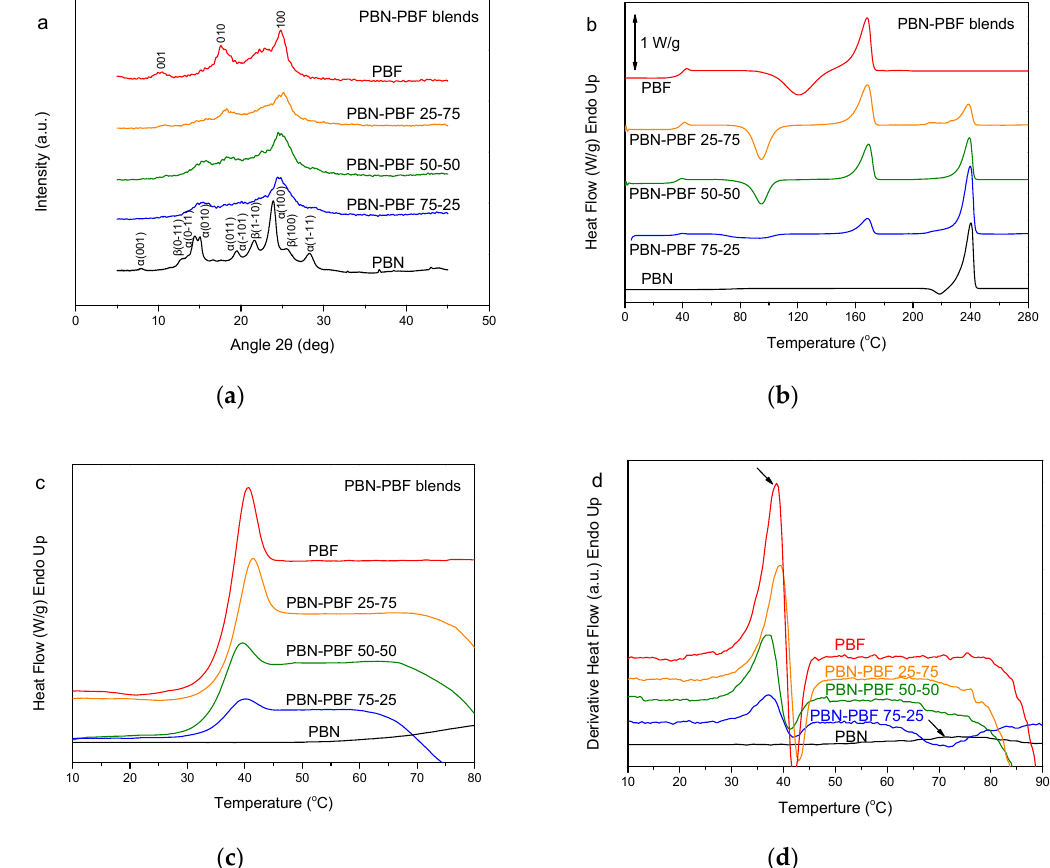
Figure 5. ( a ) WAXD patterns, ( b ) DSC traces of the melt-quenched samples upon heating, ( c ) zoom of the DSC traces in the region of T g , and ( d ) derivative heat flow for the poly(butylene naphthalate) (PBN)–PBF blends.